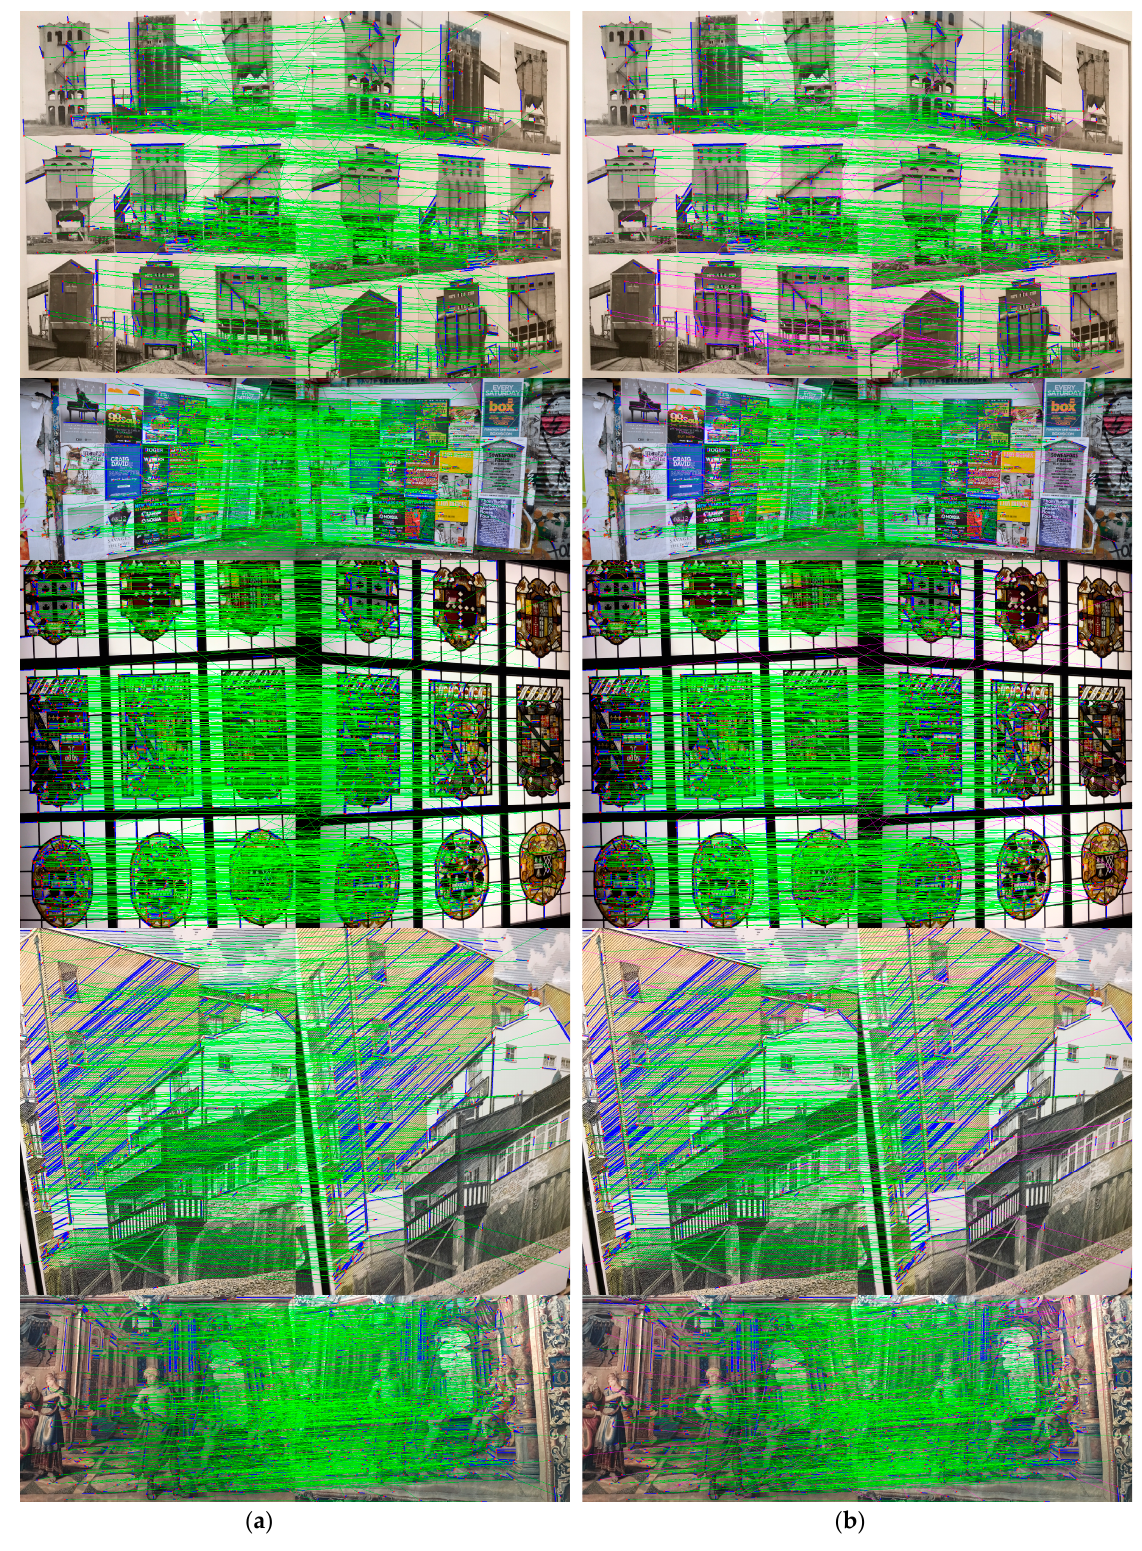
Figure 4. Comparison of line segment matching results before and after geometric constraints. Among them, the green connection line represents the matching correspondence, the pink connection line is the mismatching correspondence, the blue connection line is the matching line segment, and the red point is the endpoint of the connected corresponding line segment. ( a ) Matching before geometric constraints. ( b ) Matching after geometric constraints.